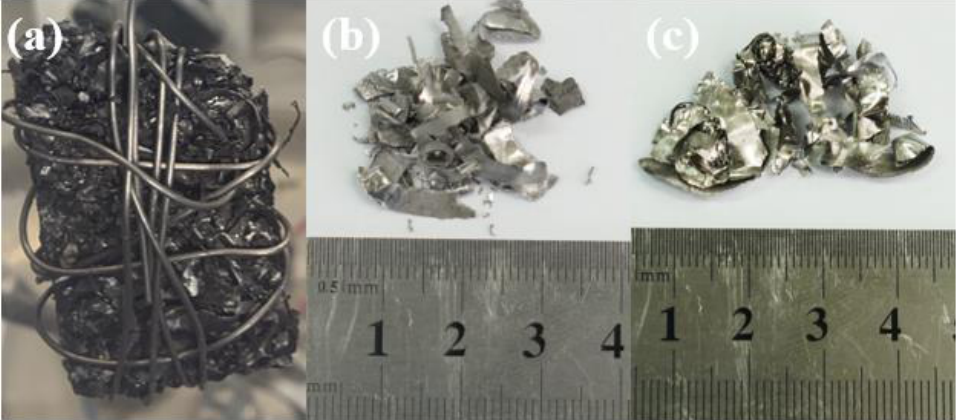
Figure 10. ( a ) Ti scrap before the electrolytic deoxidation process; ( b ) external and ( c ) internal Ti scraps after the process.